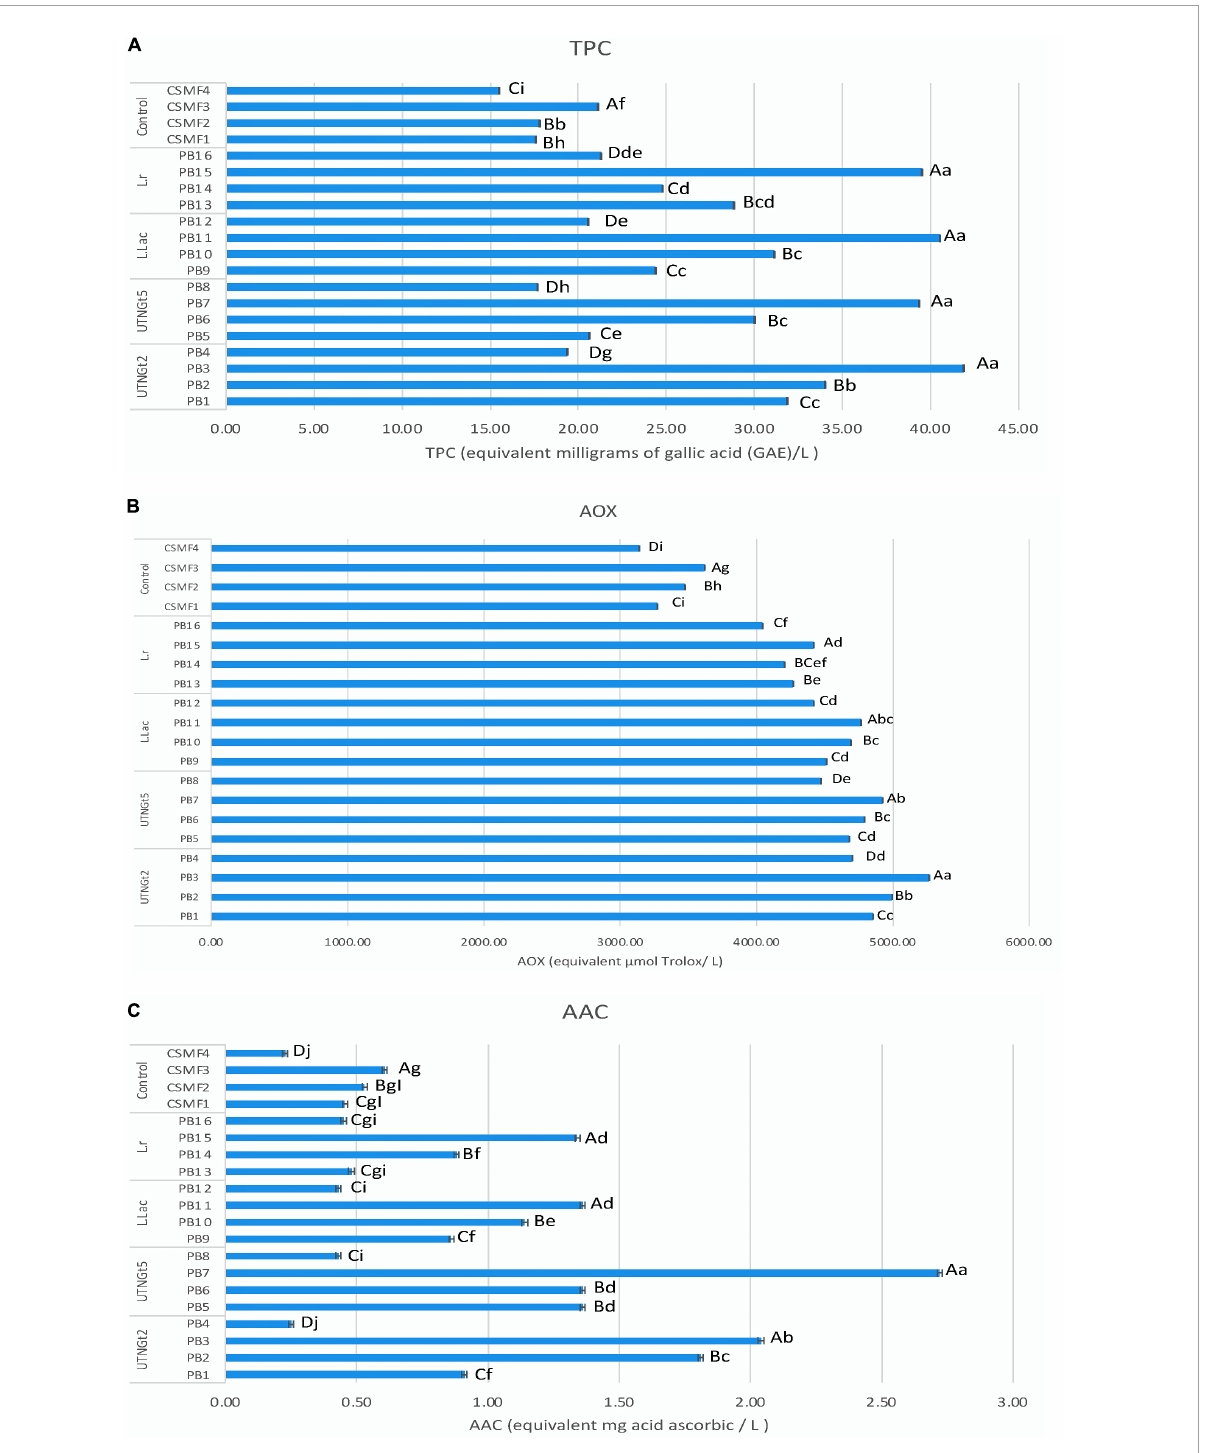
FIGURE6 Effect of bacteria on TPC (A) , AOX (B) , and AAC (C) at the end of storage (21 day). Bars are the means ± standard error. Values with different letters are significantly different p < 0.05. Small letters show the difference between the beverages (LSD with Bonferroni correction); Capital letter show the differences within the beverage group (Duncan’s test). Legend: PB1–PB4: (CSMF1–CSMF4) + UTNGt2; PB5–PB8: (CSMF1–CSMF4) + UTNGt5; PB9–PB12: (CSMF1–CSMF4) + L.Lac; PB13–PB16: (CSMF1–CSMF4) + L.r. CSMF1: semi-skimmed milk + 1% cocoa + 2% glucose; CSMF2: semi-skimmed milk + 2% cocoa + 2% glucose; CSMF3: semi-skimmed milk + 3% cocoa + 2% glucose; CSMF4: semi-skimmed milk + 2% glucose. AOX, antioxidant capacity (equivalent µ mol Trolox/L); TPC, total polyphenol content [equivalent milligrams of gallic acid (GAE)/L]; AAC, ascorbic acid (equivalent mg acid